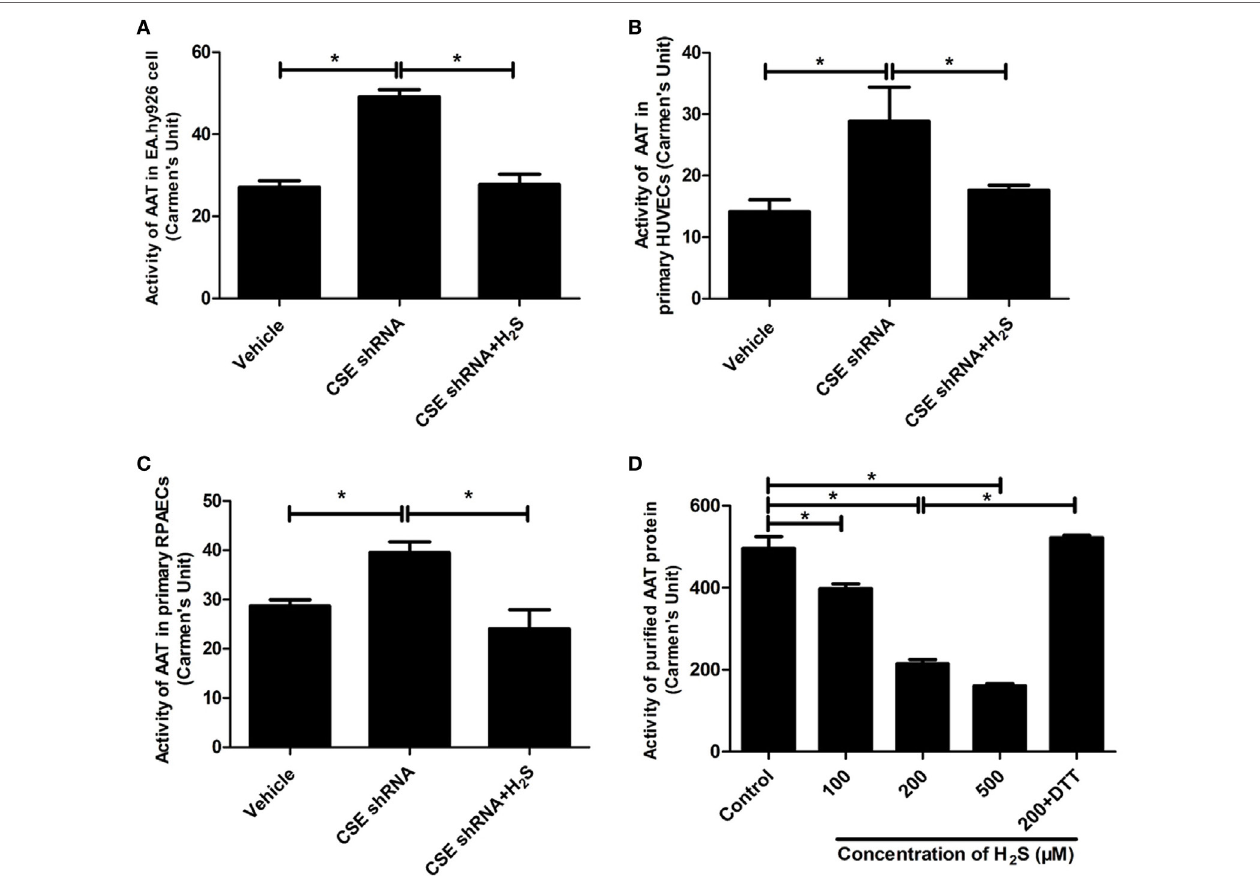
FigUre 3 | Endogenous H 2 S inhibited aspartate aminotransferase (AAT) activity in the endothelial cells and purified AAT protein. The activity of AAT in the EA.hy926 cells, primary human umbilical vein endothelial cells (HUVECs), primary rat pulmonary artery endothelial cells (RPAECs), and purified AAT protein were detected using colorimetric method. The endothelial cells were intervened by cystathionine- γ -lyase (CSE) knockdown, then pretreated with or without H 2 S donor (200 µM) for 24 h. (a) AAT activity in the EA.hy926 cells. (B) AAT activity in the primary HUVECs. (c) AAT activity in the primary RPAECs. (D) AAT activity of purified AAT protein. Different concentrations of H 2 S donor NaHS (100, 200, and 500 µM) were incubated with purified AAT protein from pig heart for 2 h. In the 200 µM H 2 S plus DTT treatment, purified AAT protein was pretreated with NaHS (200 µM) for 1 h, and then incubated with 1 mM DTT for a further 1 h in the continuous presence of NaHS. * P < 0.05. Data are expressed as means ± SEM, and all experiments were performed independently for at least three